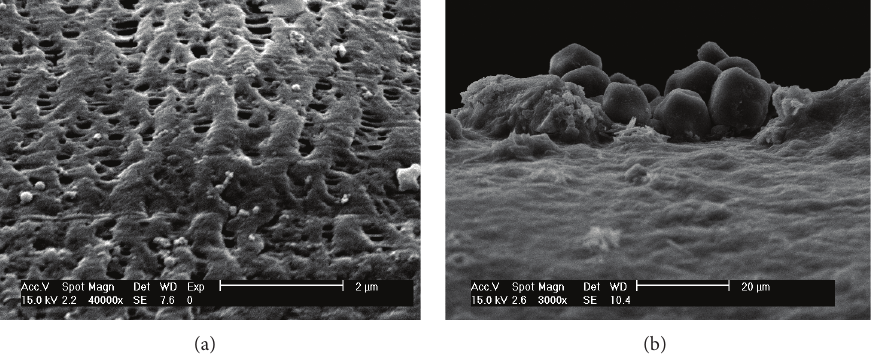
Figure 6: The scanning electron micrograph of control hollow fiber membrane surface (a) and polluted membrane from MBfR (b).